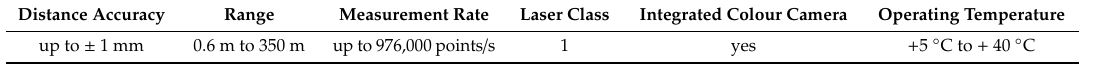
Table 1. Main Features of the FARO FocusS 350 terrestrial laser scanner (TLS).